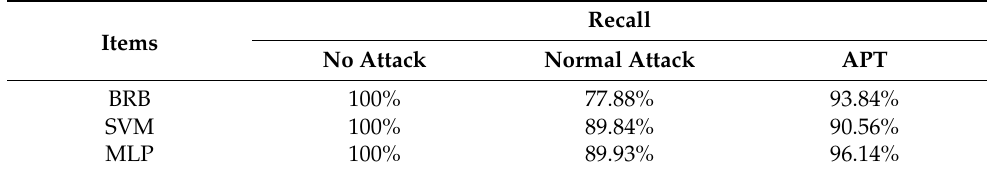
Table 13. The comparison of recall rate.